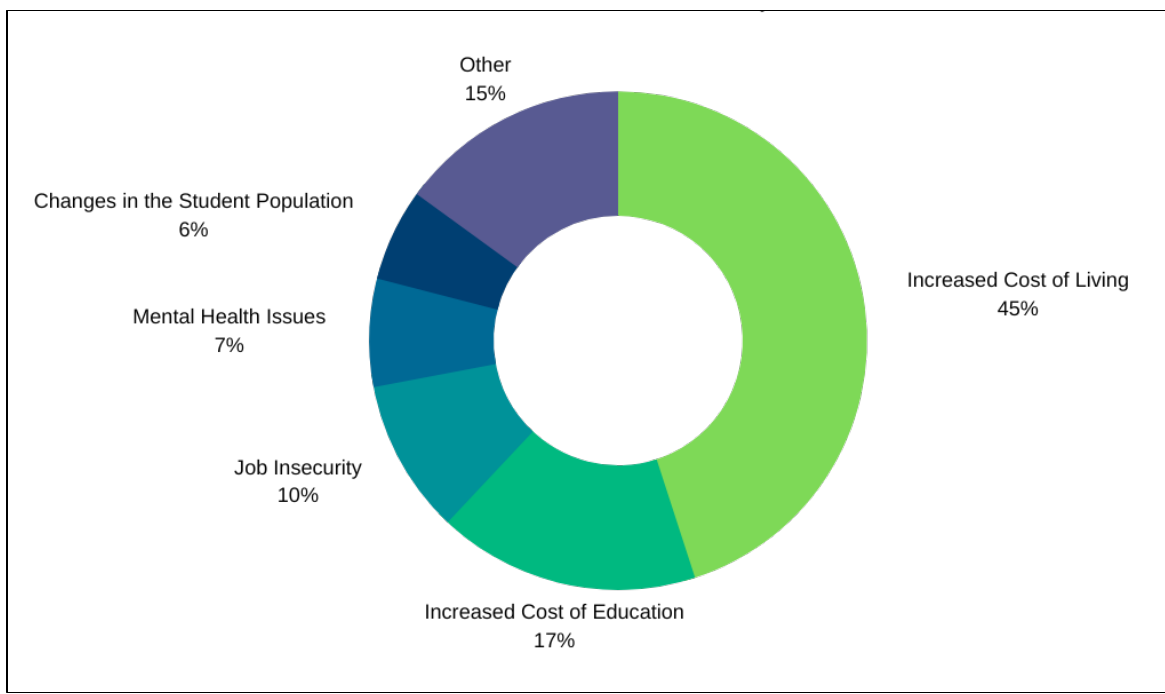
Figure 1. Perceived Contributors to Food and Housing Insecurity Among Students, Based on Workshops with Students